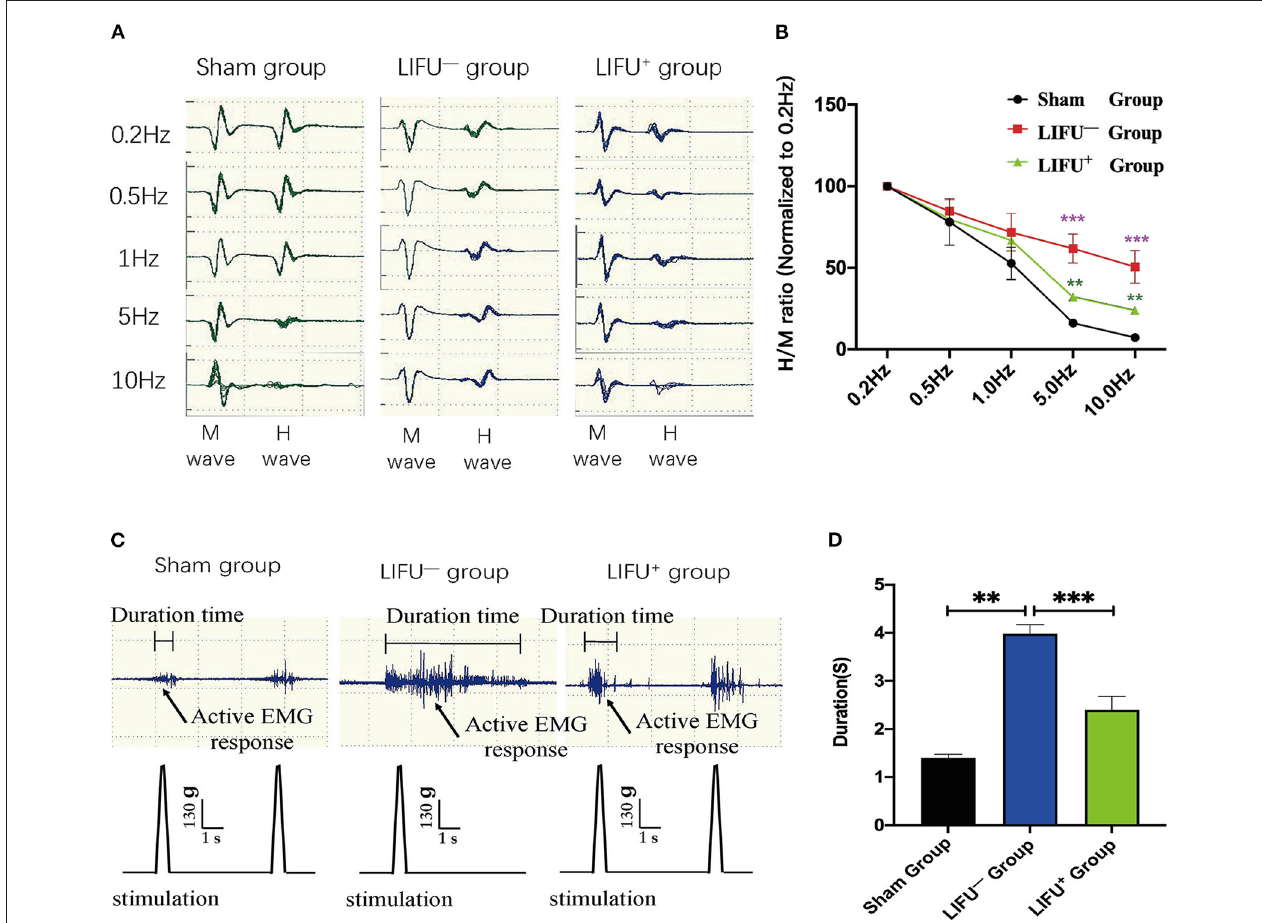
FIGURE 4 | Change in frequency-dependent depression (FDD) and electromyograph (EMG) after 4 weeks of LIFU stimulation. (A) A typical H max /M max recording over a series of 20 stimulations at 0.2, 0.5, 1, 5, and 10Hz. The amplitude of the H-reflex decreased with increasing stimulus frequency. (B) FDD was normalized to intact (0.2Hz) and showed significant differences among the different groups at 5 and 10Hz stimuli; *** P < 0.001, compared with the sham group; ** P < 0.05, compared with the LIFU − group; one-way ANOVA with LSD test; n = 10, mean ± SEM. (C) a typical EMG recording; the black arrow shows the active EMG response following LIFU stimulation. (D) after 4 weeks of LIFU treatment; the durations of the EMGs were significantly different among the three groups; ** P < 0.01 in the LIFU − group compared with the sham group; *** P < 0.001 in the LIFU + group compared with the LIFU − group; one-way ANOVA with LSD test; n = 10, mean ±